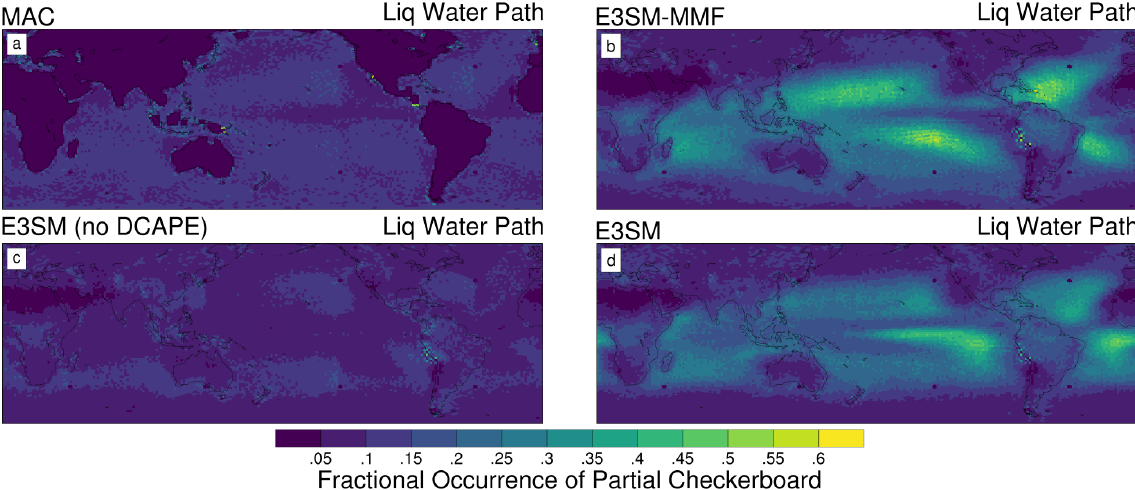
Figure 9. Maps of fractional occurrence of partial checkerboard patterns (see text) for MAC-LWP (a) , E3SMv2 without DCAPE (b) , standard E3SMv2 with DCAPE (c) , and E3SM-MMF (d) . All data are on the ne30pg2